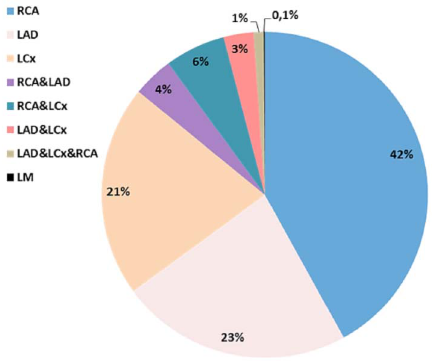
Figure 3. Coronary location of CTO observed at angiography. RCA=right coronary artery, LAD=left descending coronary